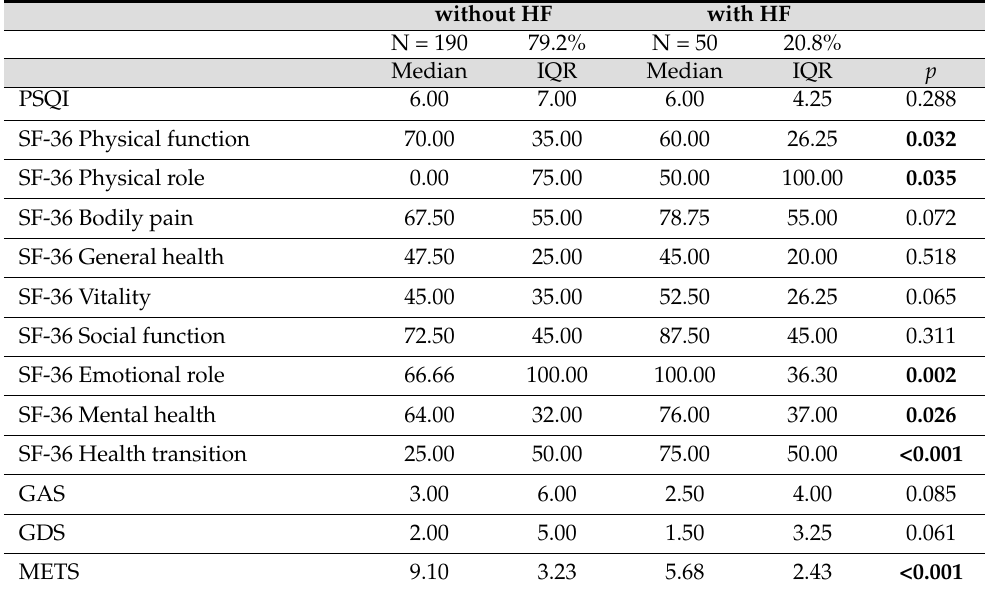
Table 6. Comparison of final data based on heart failure.